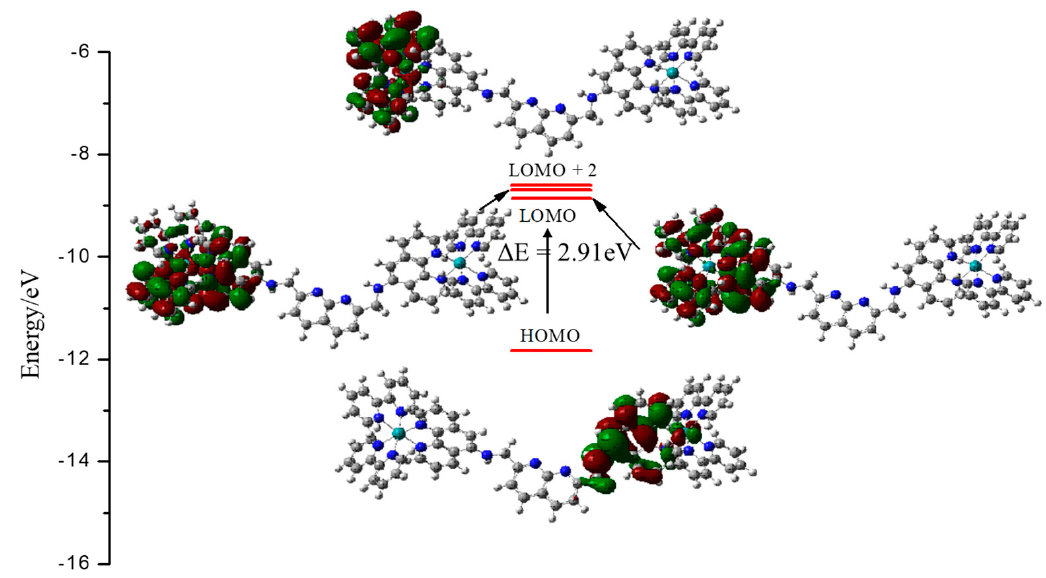
Figure 1. Electron distribution and energy diagram of HOMO and LUMO orbitals for the complex [{Ru(bpy) 2 } 2 ( µ 2 -H 2 L)] 4 +